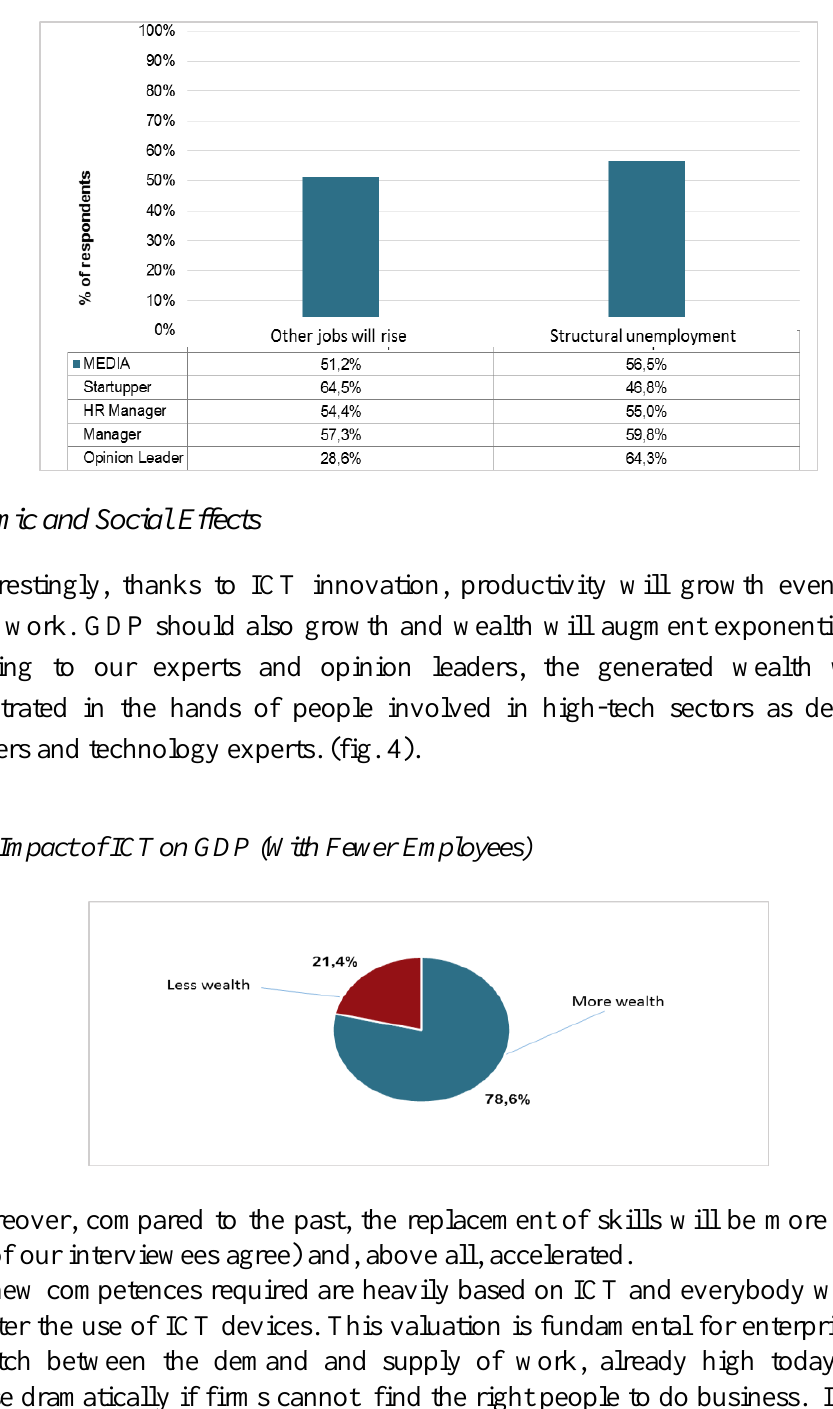
Figure 3. Can We Expect Structural Unemployment or Will We Find Solutions or Some Way Out.